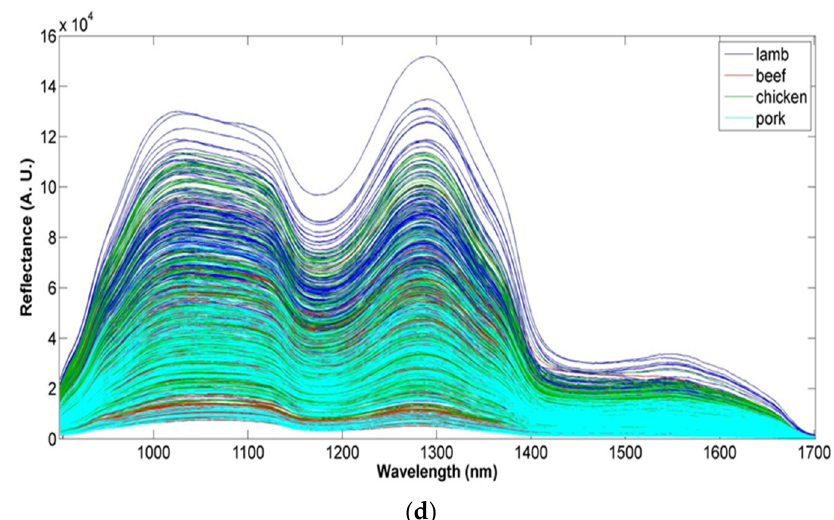
Figure 2. ( a ) Vis-NIR spectra of intact meat with smoothing, ( b ) Vis-NIR spectra of ground meat with smoothing, ( c ) raw NIR spectra of intact meat, ( d ) raw NIR spectra of ground meat. Blue: lamb, red: beef, green: chicken, turquoise: pork.